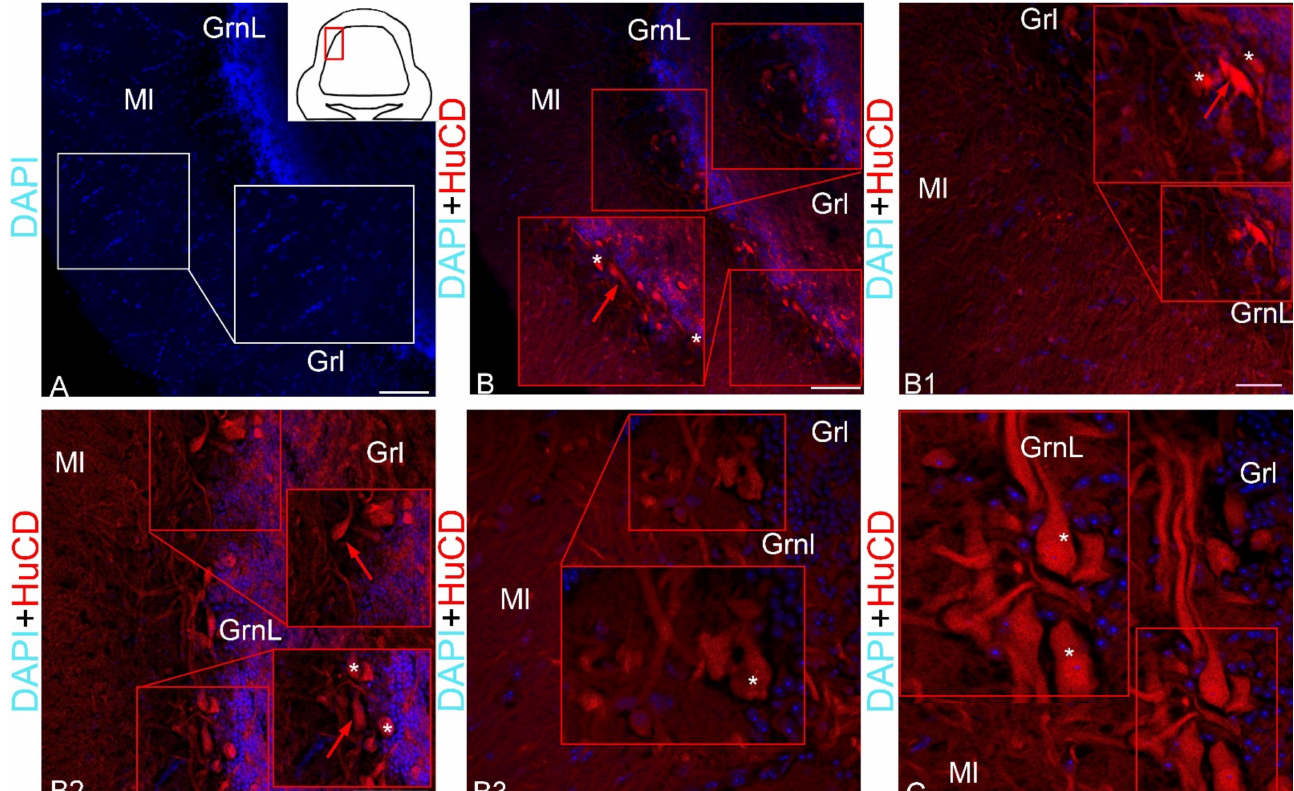
Figure 3. Micrographs showing HuCD immunofluorescence in the ganglionic layer of the lateral region of the cerebellum in juvenile chum salmon, O. keta , at 90 days after a single injection of the rAAV into the cerebellar body. ( A ) DAPI staining with a pictogram showing the lateral region of the cerebellum (in a red box), clusters of DAPI-positive nuclei (outlined by a white box); ML, molecular layer; Grl, granular layer; Grnl, ganglionic layer. ( B ) Piriform Purkinje cells (PC) (indicated by a white asterisk) and eurydendroid cells (EDC) (indicated by red arrows in a red box). ( B1 ) Intense immunofluorescence of HuCD in PC and EDC; for designations, see ( B ). ( B2 ) Intensely labeled PCs and EDCs forming clusters of 2–3 (red inset); for designations, see ( B ). ( B3 ) Isolated clusters of HuCD+ PCs and EDCs containing DAPI-stained nuclei and also proximal segments of ascending HuCD+ PC dendrites; for designations, see ( B ). ( C ) Single HuCD+ bipolar EDCs and pear-shaped PCs with proximal HuCD+ dendritic patches; for designations, see ( B ). Laser scanning confocal microscopy. Scale bar: ( A , B ) 100 µ m; ( B1 , B2 ) 50 µ m; ( B3 , C ) 20 µ